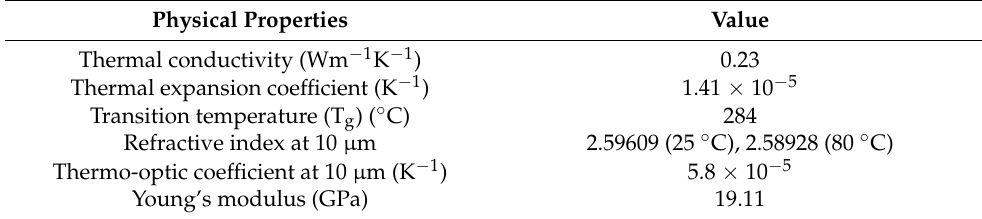
Table 1. The physical properties of the chalcogenide glass (NBU-IR1).